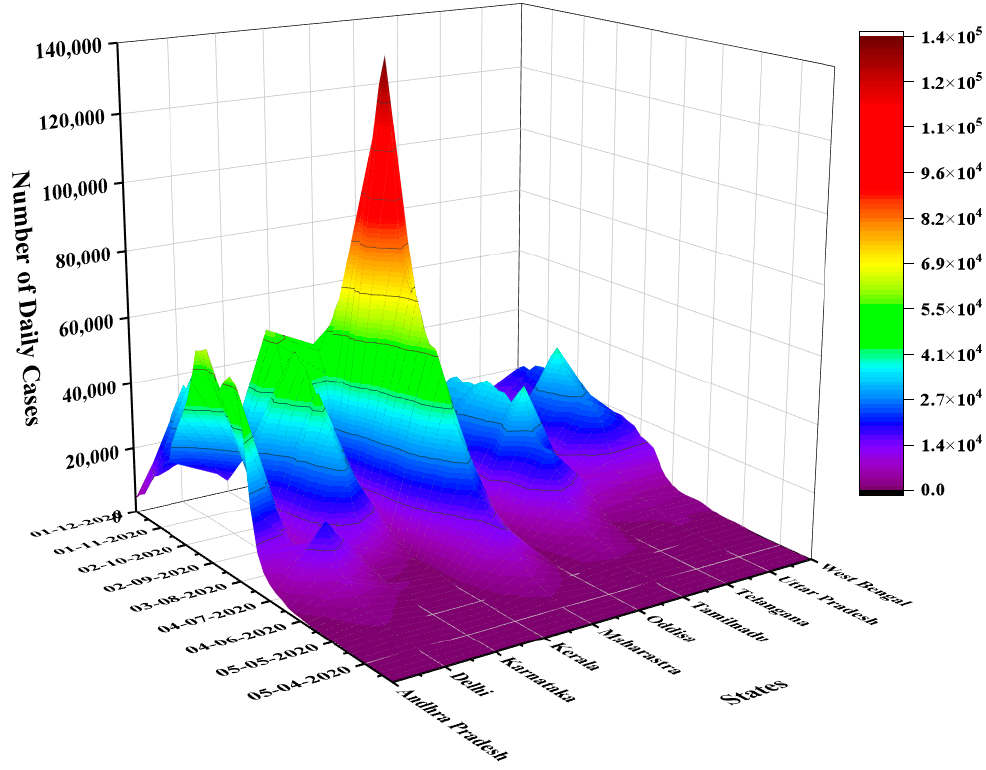
Figure 4. COVID-19 top 10 most affected states in India.